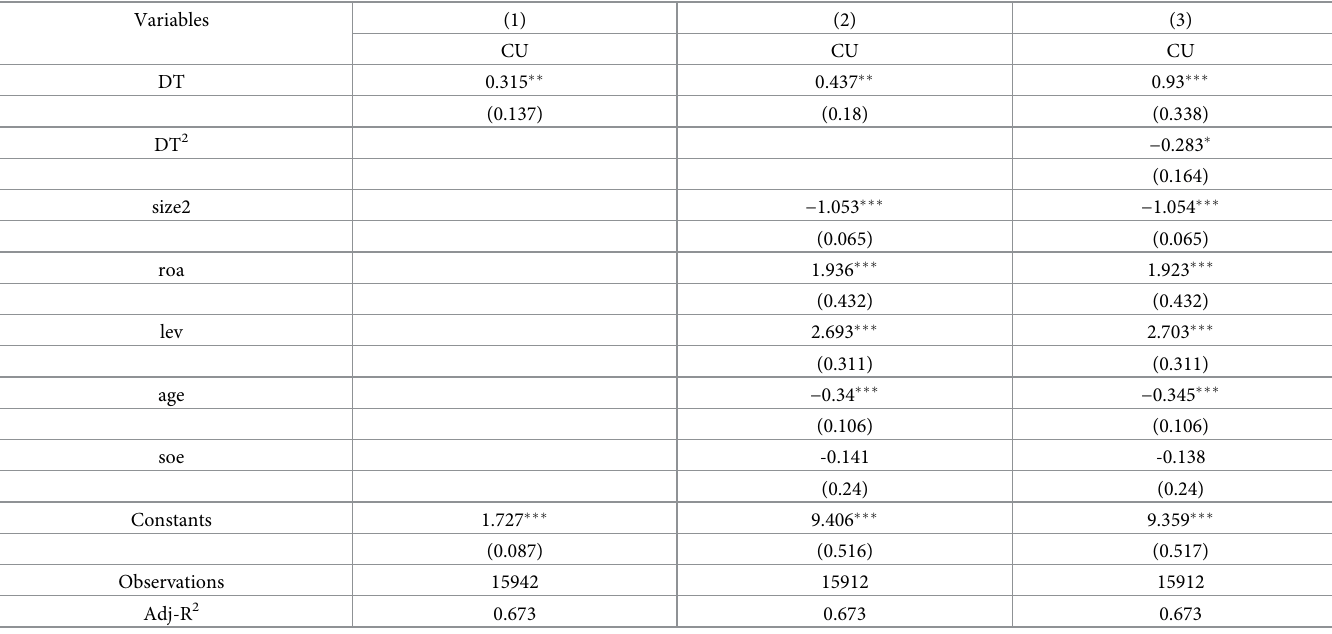
Table 3. Benchmark regression